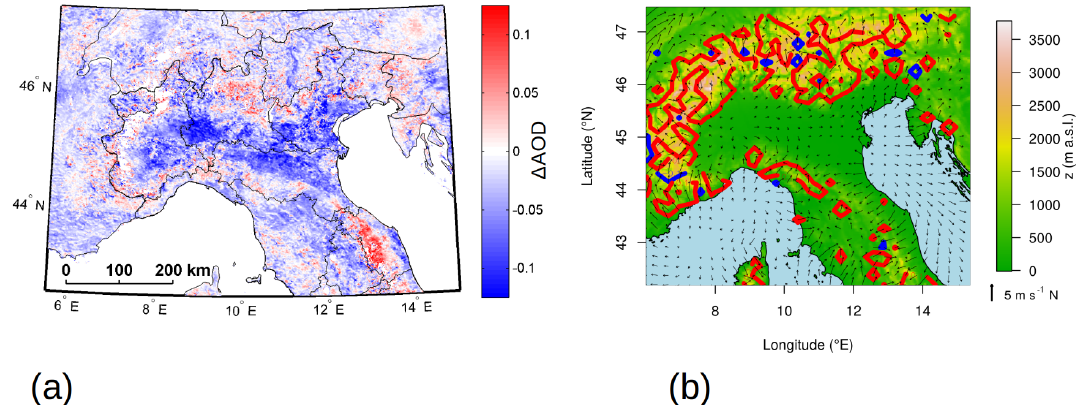
Figure 8. (a) Average difference between AOD estimated from Aqua and Terra satellites during 27–31 August 2015 using the MAIAC algorithm. (b) Horizontal wind velocity from COSMO (arrows); vertical velocity (red and blue contours, ± 0 . 1ms − 1 ) over the same domain and the same hours as in (a)